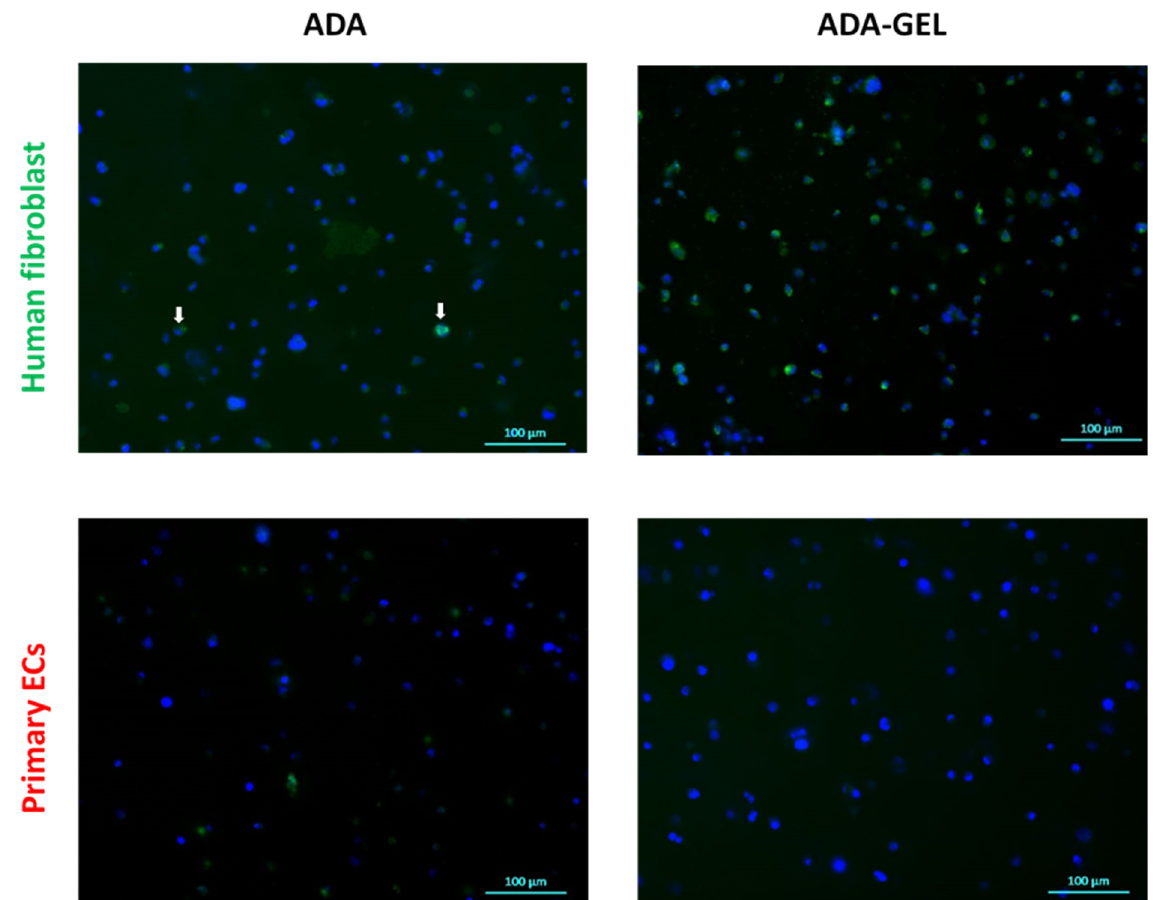
Figure 8. Immunofluorescence staining of proliferating cells (green channel) after 72 h of incubation. Representative images show Ki-67 expression in primary ECs and human fibroblast grown in ADA and ADA-GEL. Nuclei: Hoechst (Blue), Ki-67: Alexa Fluor 488 (green). The white arrows indicate scarce fibroblasts in ADA positive for Ki-67.